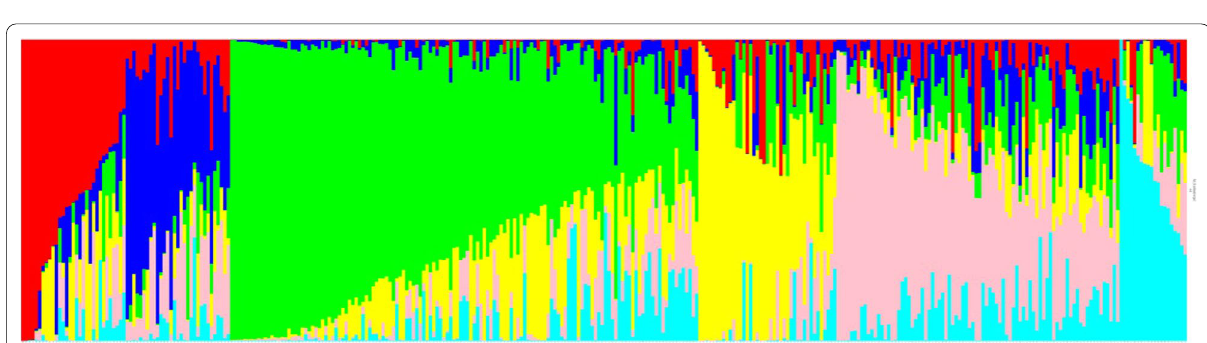
Fig. 3 Classification of O. rufipogon population into six sub-populations represented by different colors: red, blue, green, yellow, pink, cyan